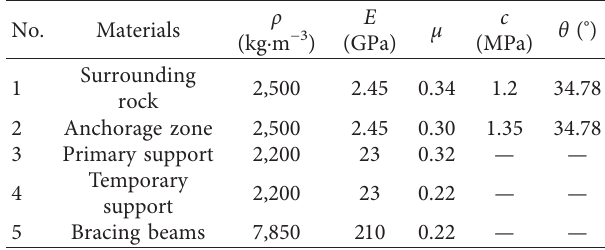
Table 2: Parameters of the material.